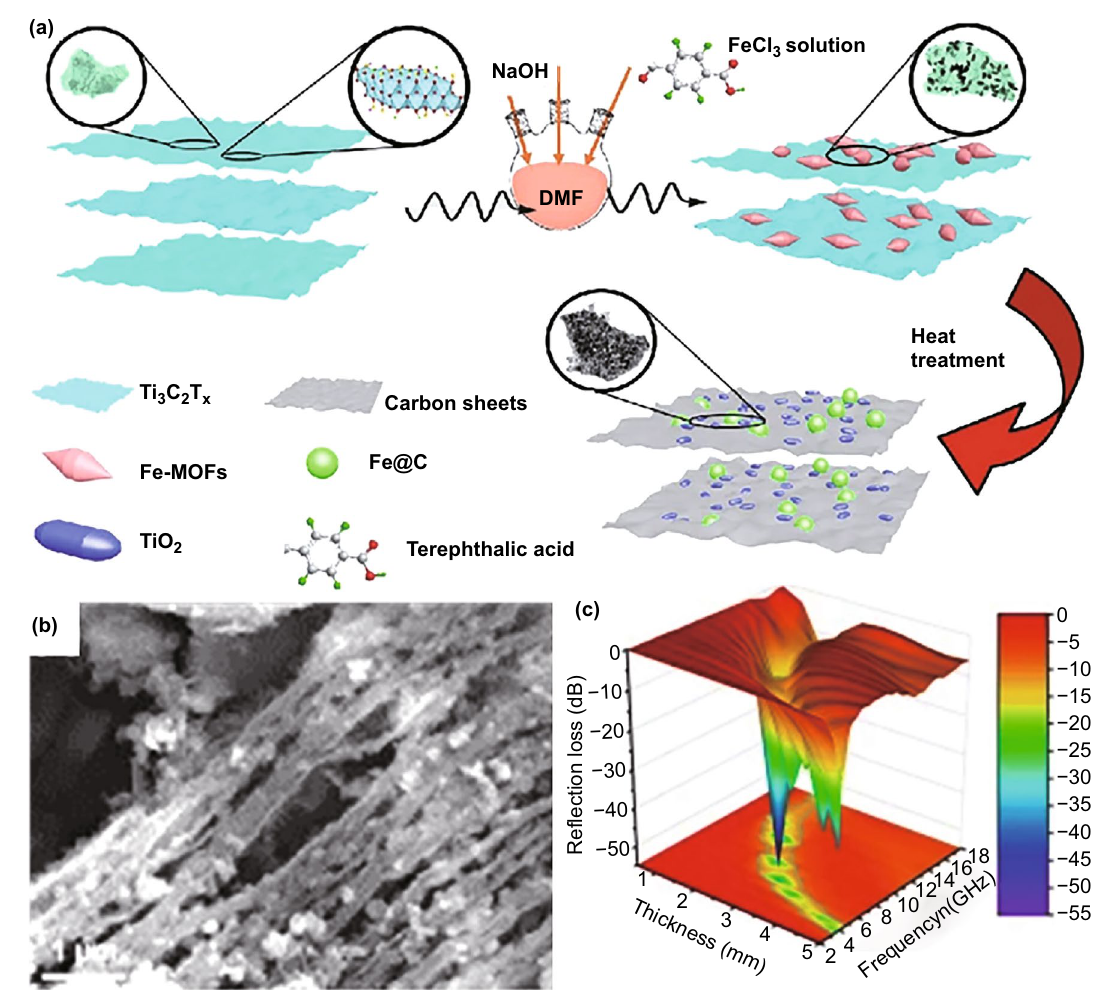
Fig. 6 a Schematic representation of the facile synthesis route of the Fe&TiO2@C. b SEM image and c 3D RL map of Fe&TiO2@C. Repro- duced with permission from Ref. [116]. Copyright © 2020